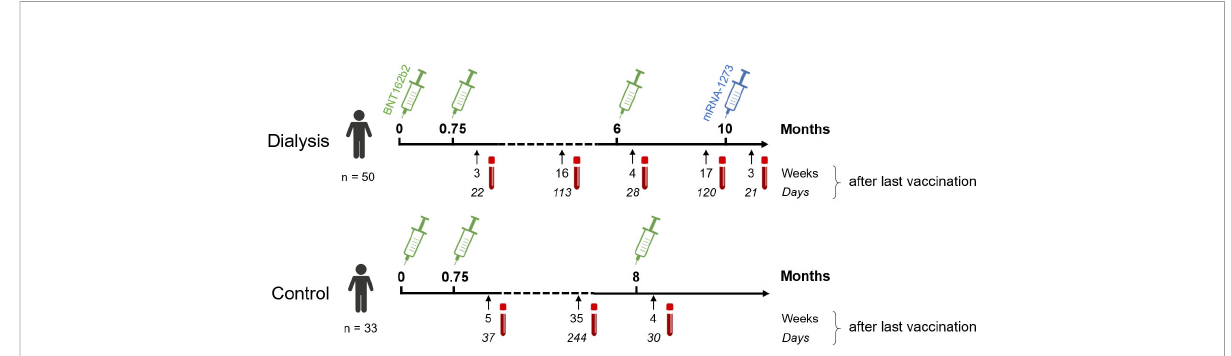
FIGURE 1 Participant recruitment scheme for longitudinal vaccination response analysis in haemodialysis patients after triple BNT162b2 and fourth full- dose mRNA-1273. Patients on haemodialysis (n = 50) and healthcare workers as controls (n = 33) were triple-vaccinated with BNT162b2 (green syringe) followed by a 100 µg (full) dose of mRNA-1273 (blue syringe) for dialysed individuals only. Sampling and vaccination schedule is given in days and weeks as